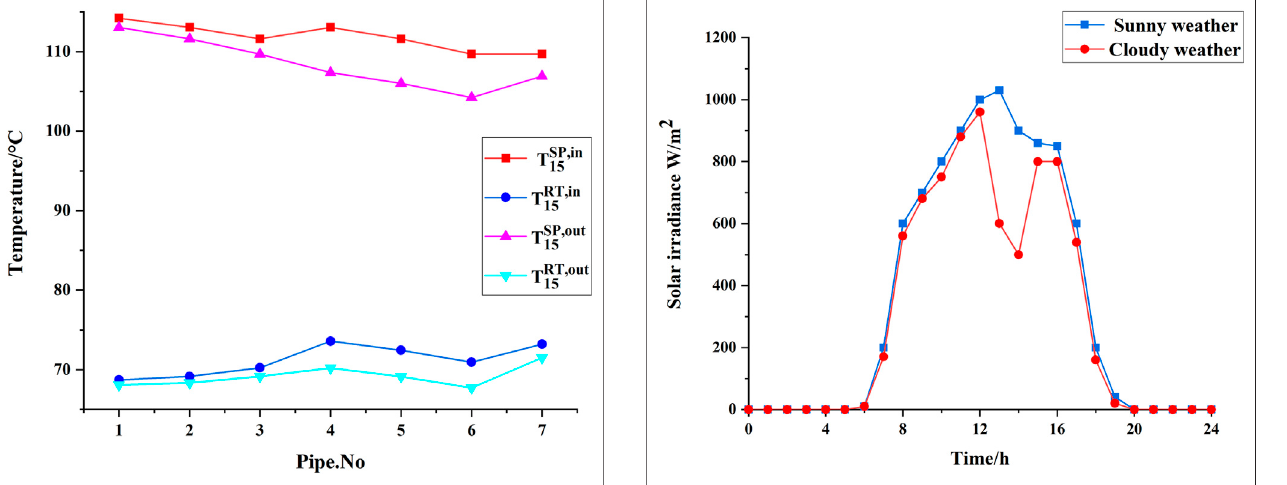
FIGURE 14 | The measured solar irradiation.